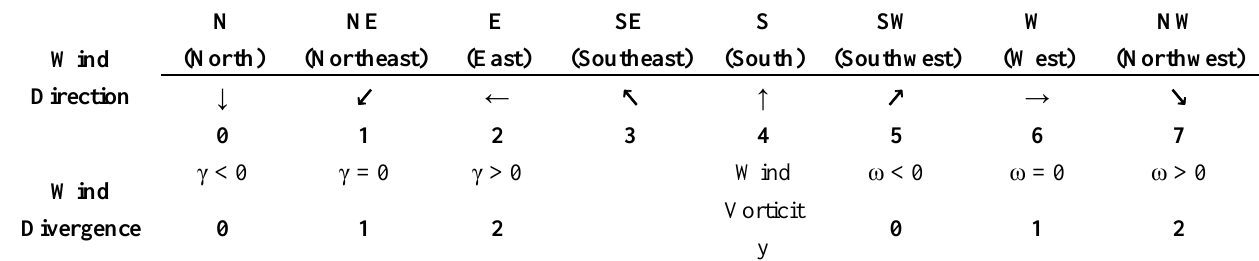
Table 3. Categories of the discrete scales of wind direction, divergence, and vorticity .